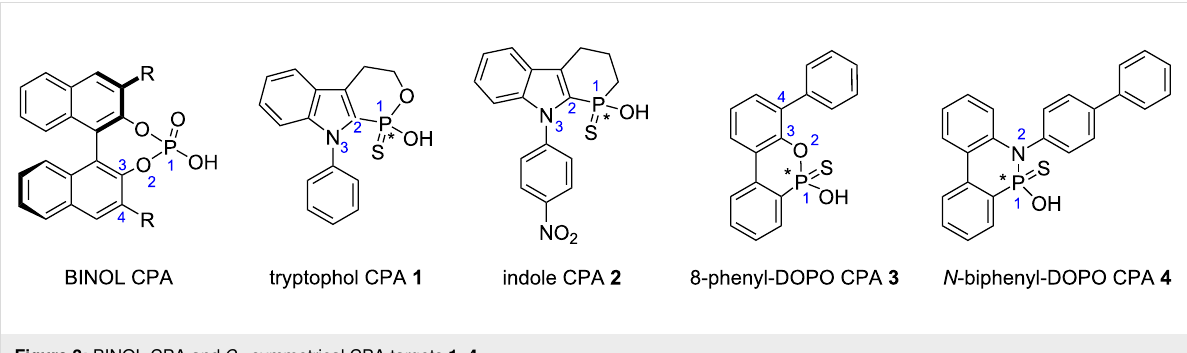
Figure 3: BINOL CPA and C 1 -symmetrical CPA targets 1 – 4